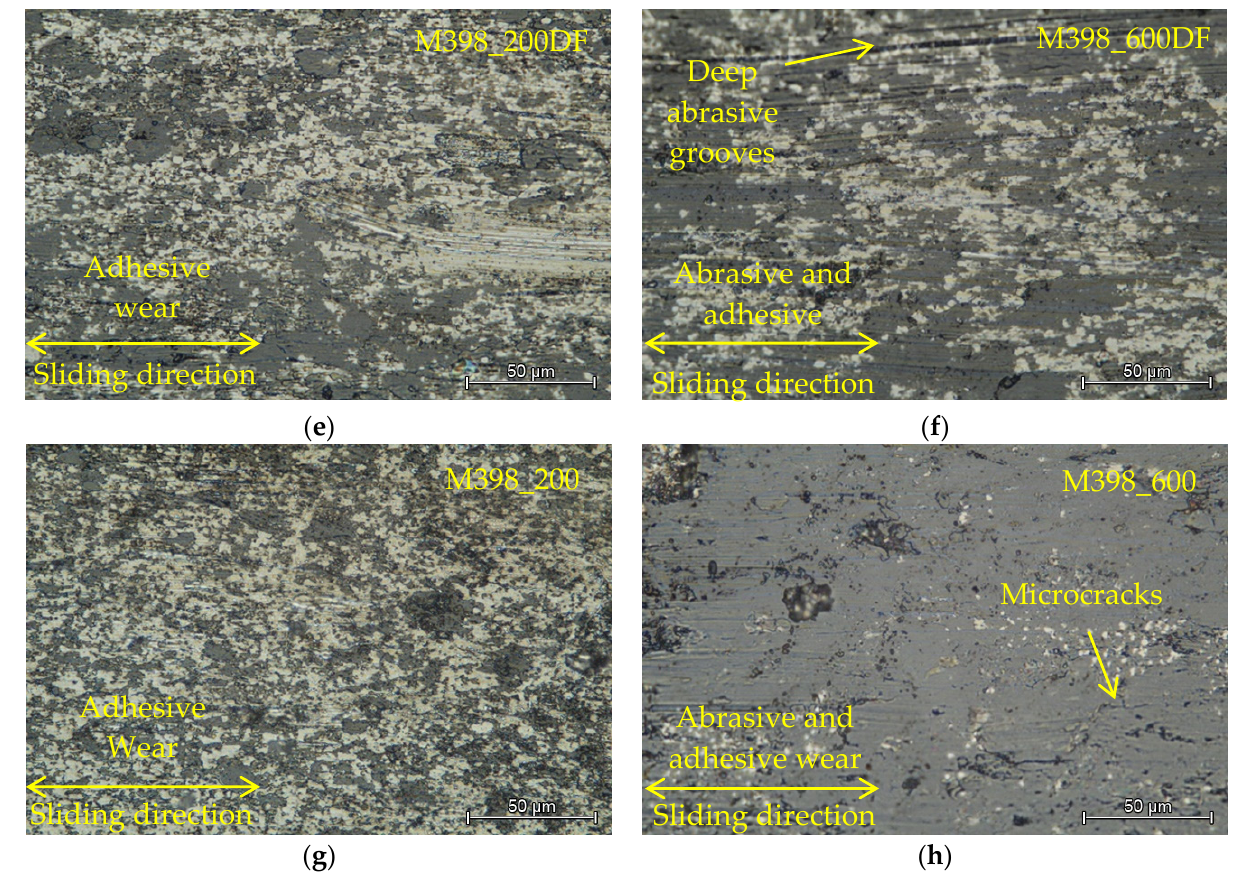
Figure 12. Wear analysis of worn surfaces M390 and M398: ( a ) M390_200DF, ( b ) M390_600DF, ( c ) M390_200, ( d ) M390_600, ( e ) M398_200DF, ( f ) M398_600DF, ( g ) M398_200, and ( h ) M398_600.